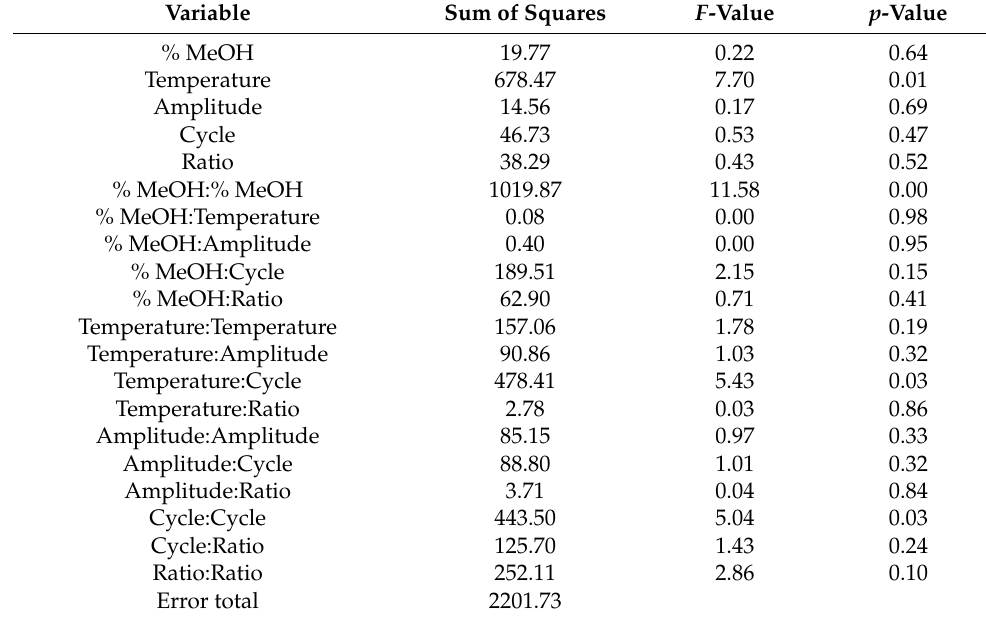
Table 3. Results from the BBD–RSM for Antioxidant Activity